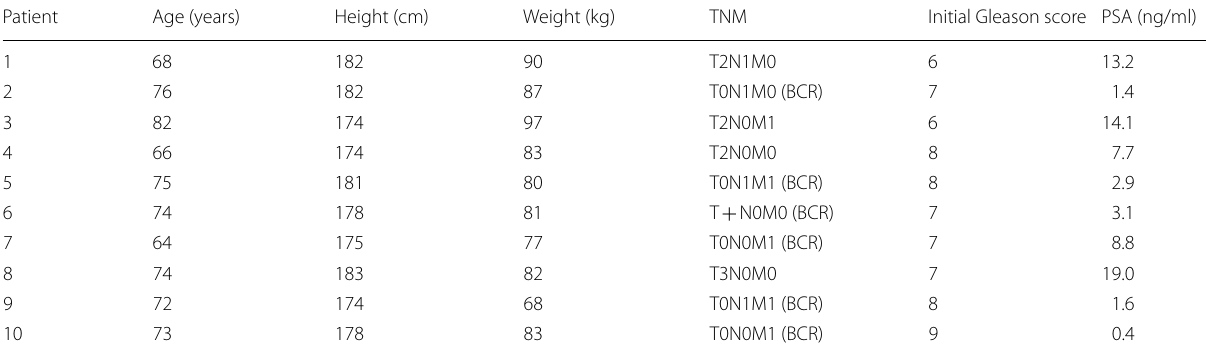
Table 1 Patient characteristics for PSMA study